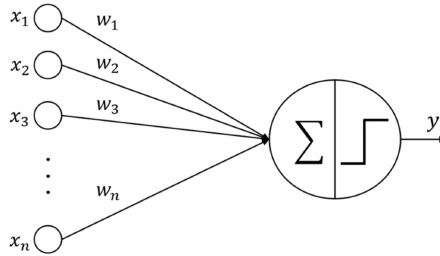
Figure 1. Artificial neuron diagram.